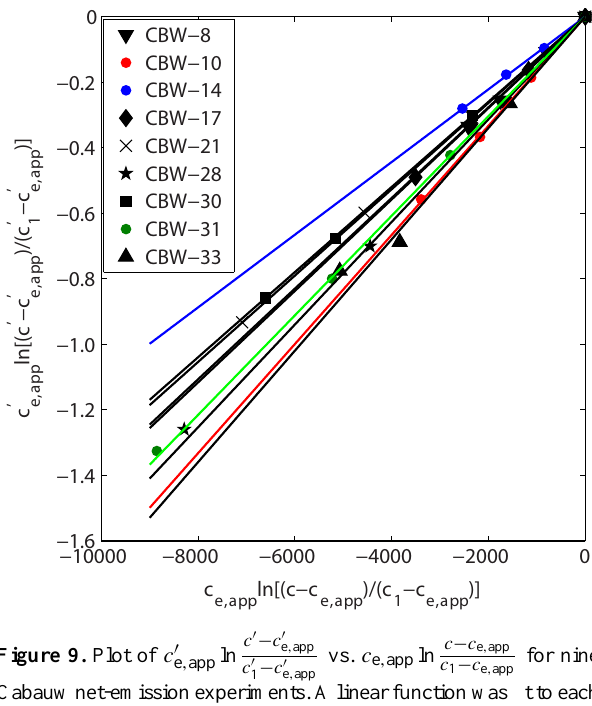
Figure 9. Plot of c (cid:48) e , app ln c (cid:48) − c (cid:48) e , app c − c e , app Figure 7. Plot of ln for all Speuld and vs. ln c 1 − c e , app − c (cid:48) c (cid:48) Cabauw net-emission experiments. A linear function was fit to each e , app 1 Cabauw net-uptake experiments. The slope of the linear fit to the individual data set and the slope was used to calculate the δ D soil , app data returns the fractionation factor α soil , app = 0.947 ± 0.004 (95% value for each experiment. Errors in x and y direction for each data CI). Errors in x and y direction for each data point were considered. point were One outlier (“CBW-18”) was not included in the fitting. The 95% confidence intervals of the fit line are included as dashed lines but largely overlap with the fit line.